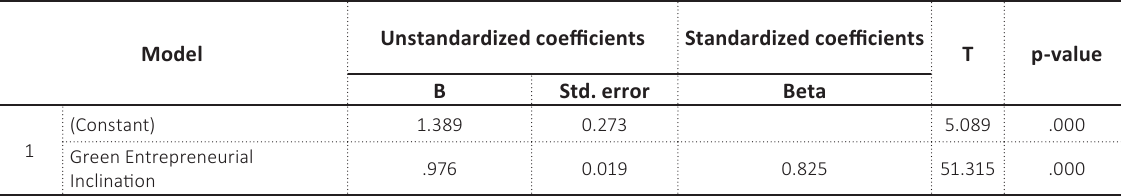
Table 12. Effect of green entrepreneurial inclination on customers’ patronage